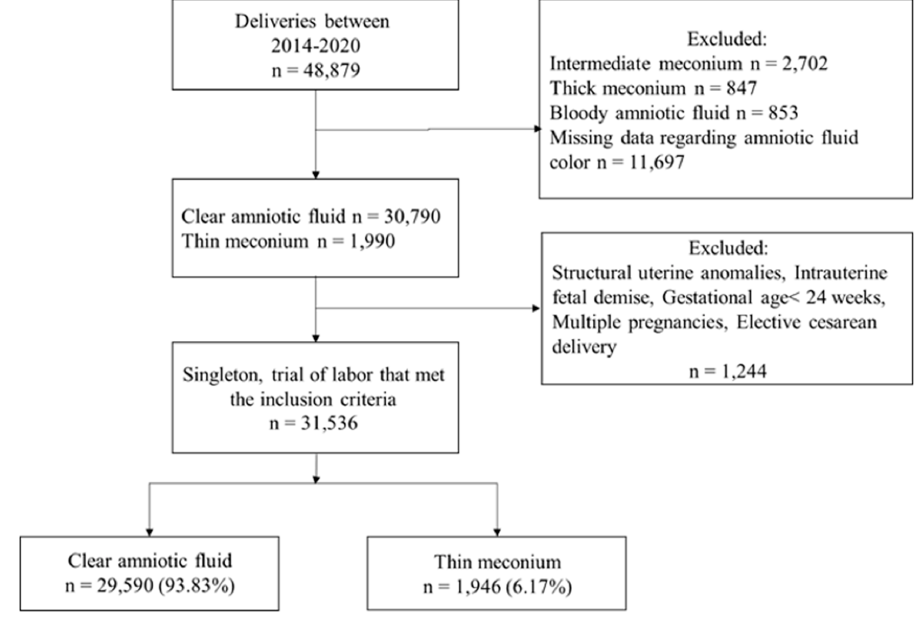
Figure 1. Study flow diagram.